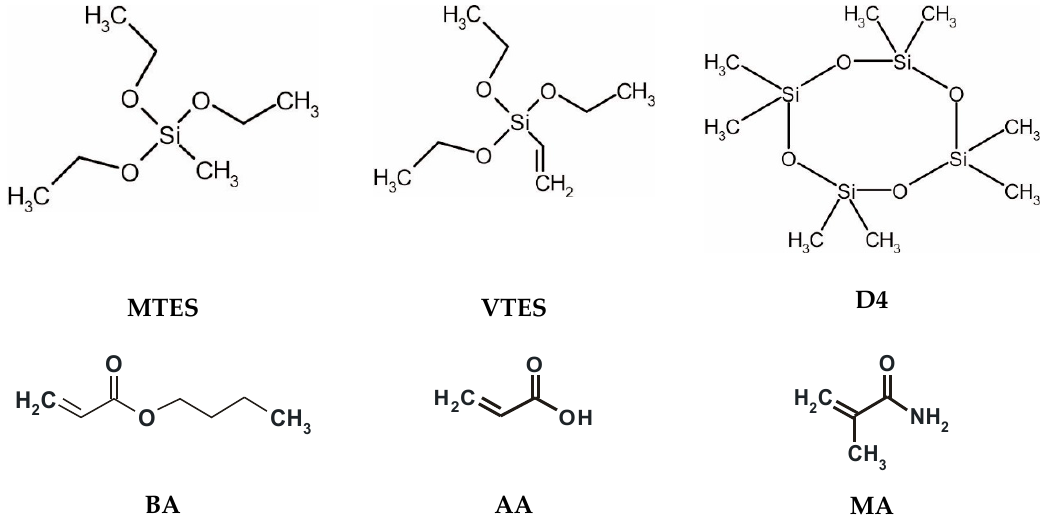
Figure 2. Structures of silicone monomers used in synthesis of silicone resin dispersions SIL 1 and SIL 2 and acrylic/styrene polymer dispersions ACR A and ACR B.